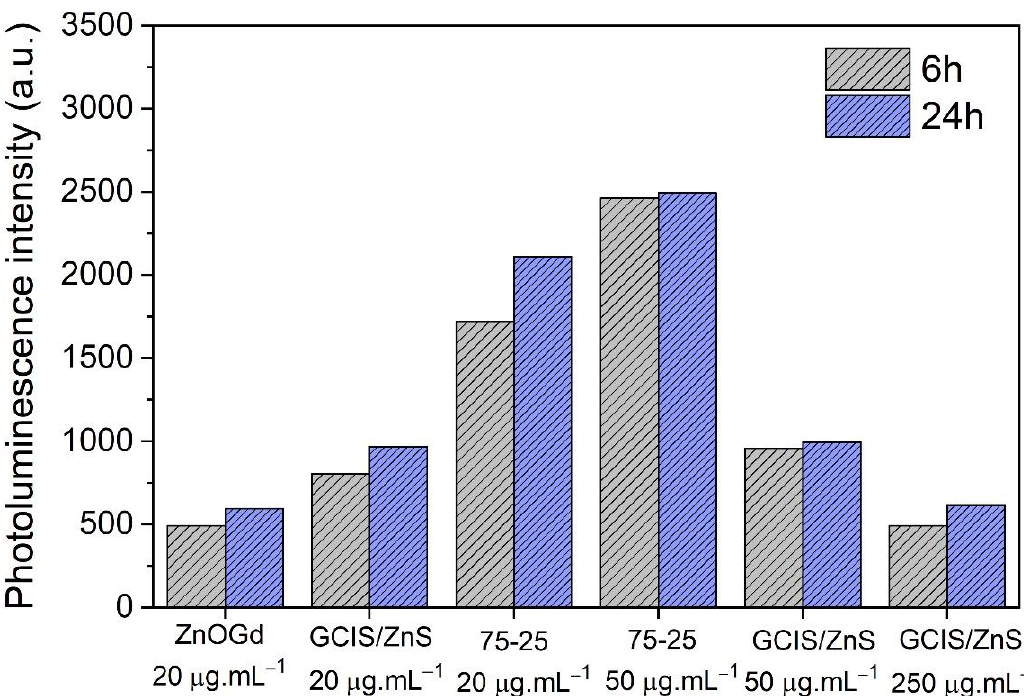
Figure 8. Cell uptake of quantum dots modified with GPTMS and dispersed in water (ZnOGd, GCIS/ZnS and ZnOGd-GCIS/ZnS (75-25)) on 3T3/NIH fibroblast cells. Cells were incubated with different concentrations for 6 h and 24 h. Cells were washed with phosphate-buffered saline (PBS) to remove the quantum dots that were not captured by the cells.